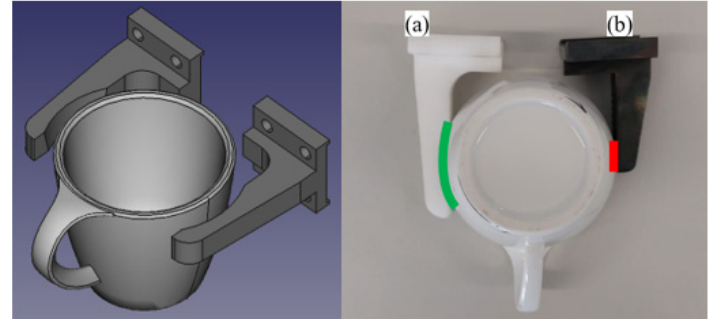
Figure 8. Model and prototype of tweezers adapted to the cup. Source: (own).